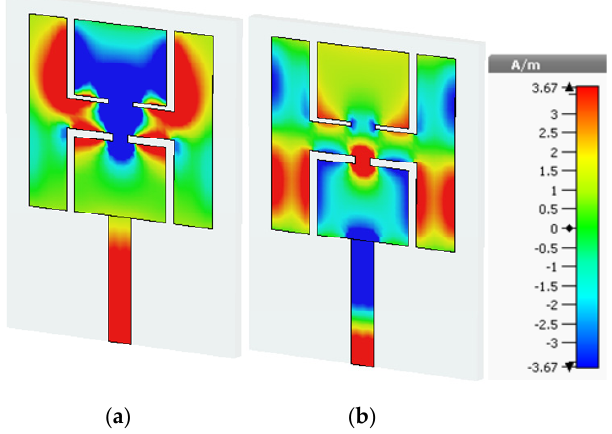
Figure 6. Surface current distribution ( a ) at 2.45 GHz and ( b ) at 5.8 GHz.